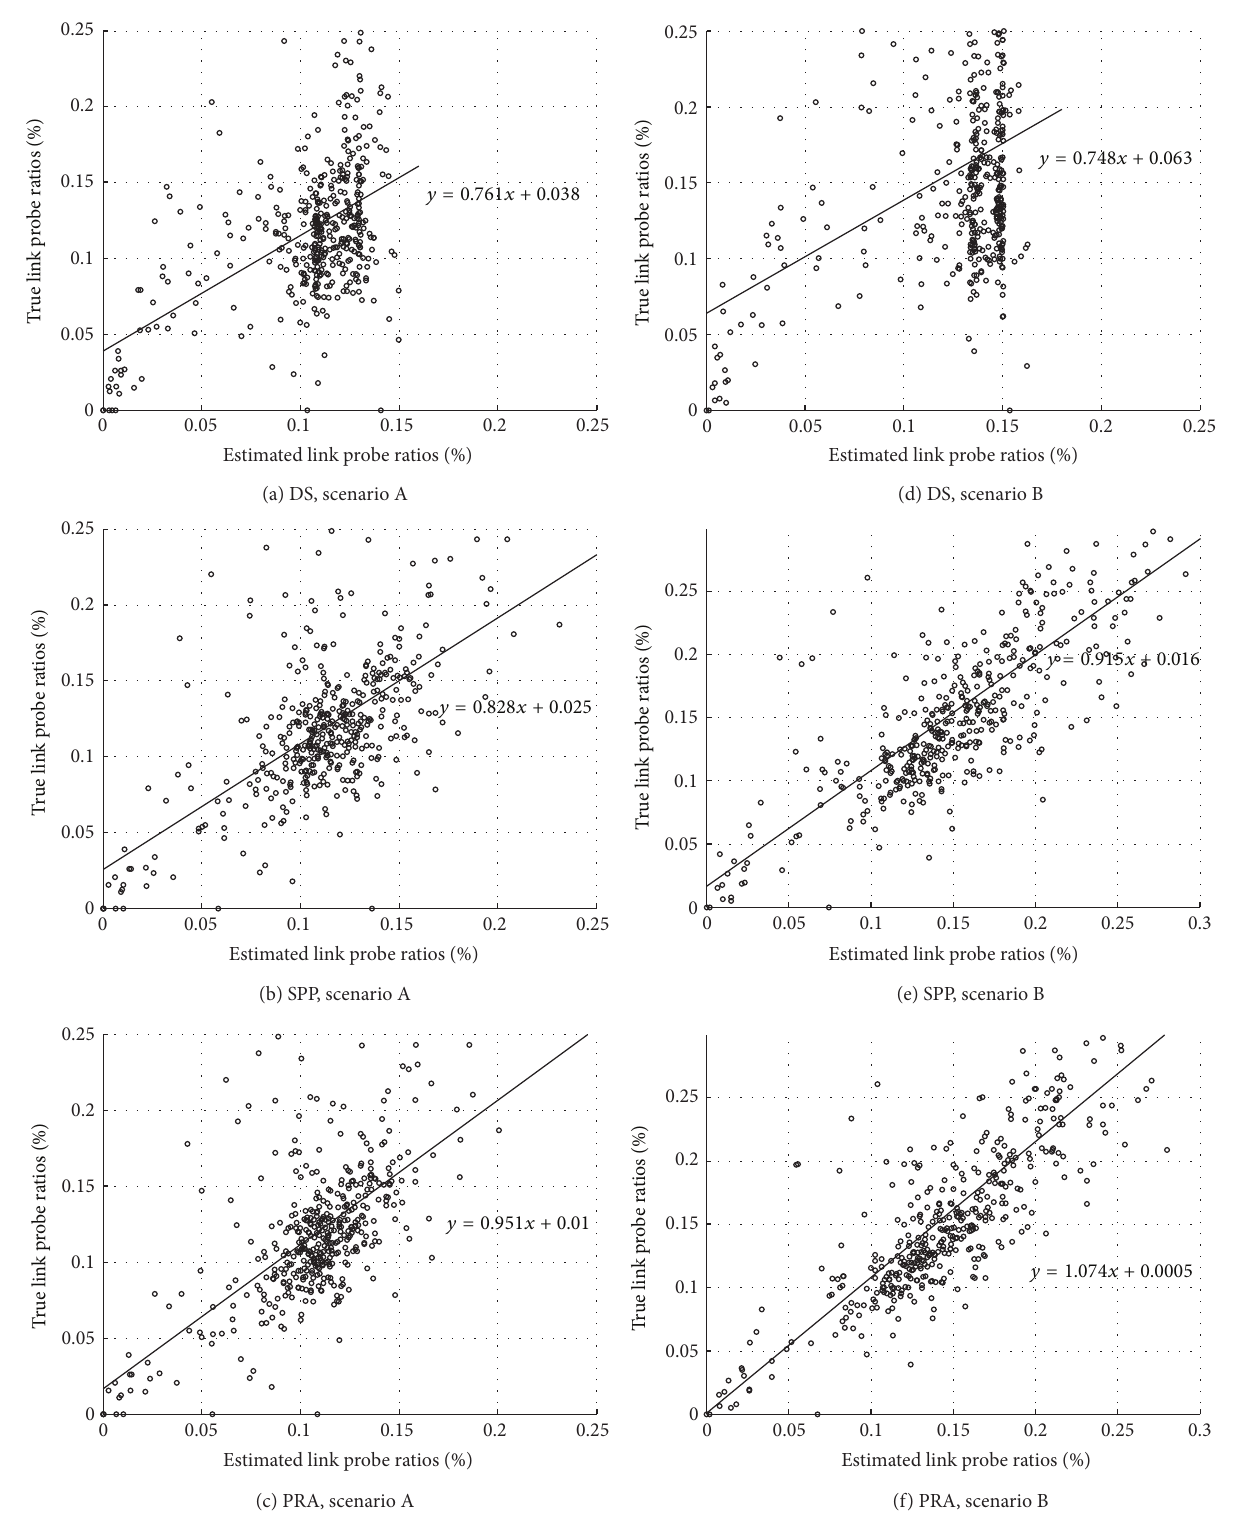
Figure 7: Scatter plots of estimated and observed link probe